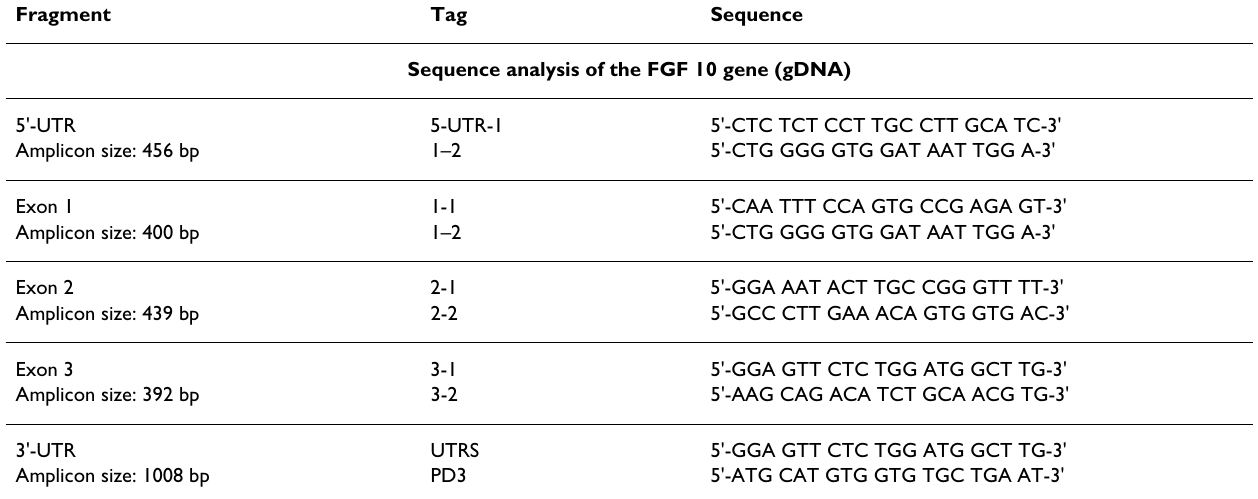
Table 1: Oligonucleotide primers for amplification and sequence analysis of FGF10 in transcript and genomic DNA, and quality controls. Fragment Tag Sequence Sequence analysis of the FGF 10 gene